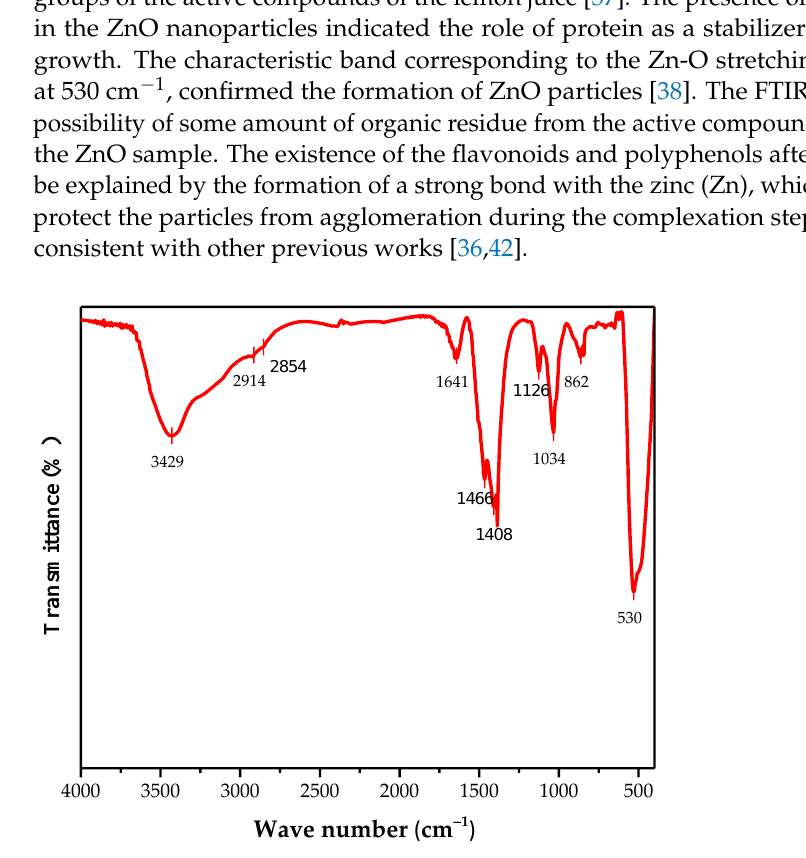
Figure 4. FTIR spectrum of the biosynthesized ZnO nanoparticles calcined at 750 °C.